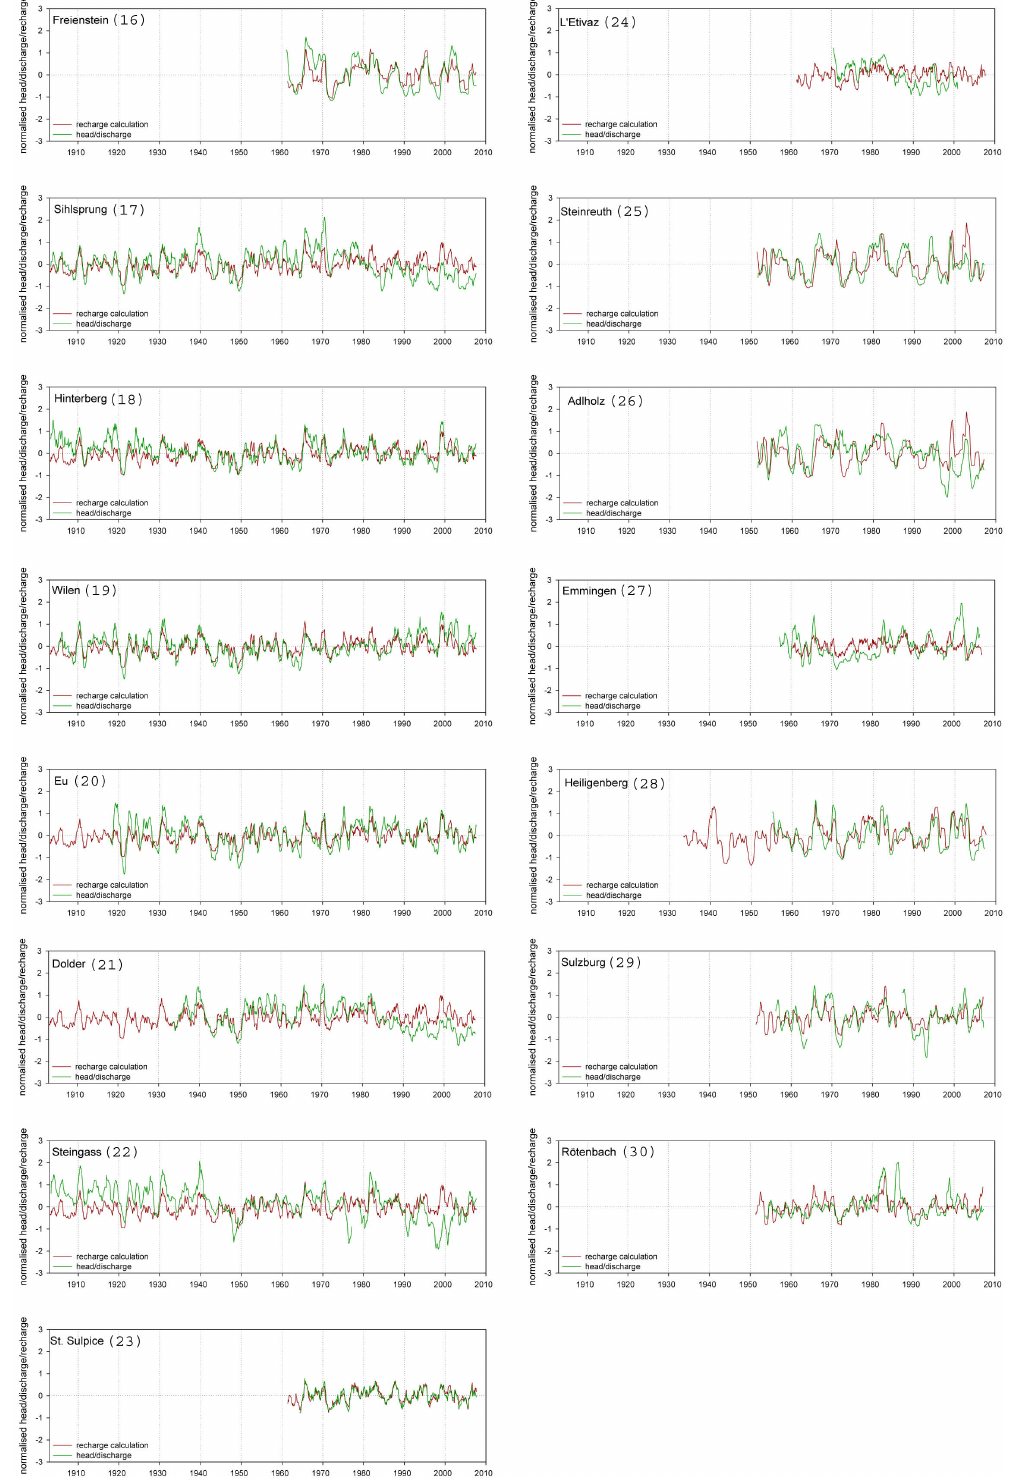
Fig. 3. Normalised monthly observed spring discharges versus calculated recharge for the different springs over periods of varying length between 1930 and